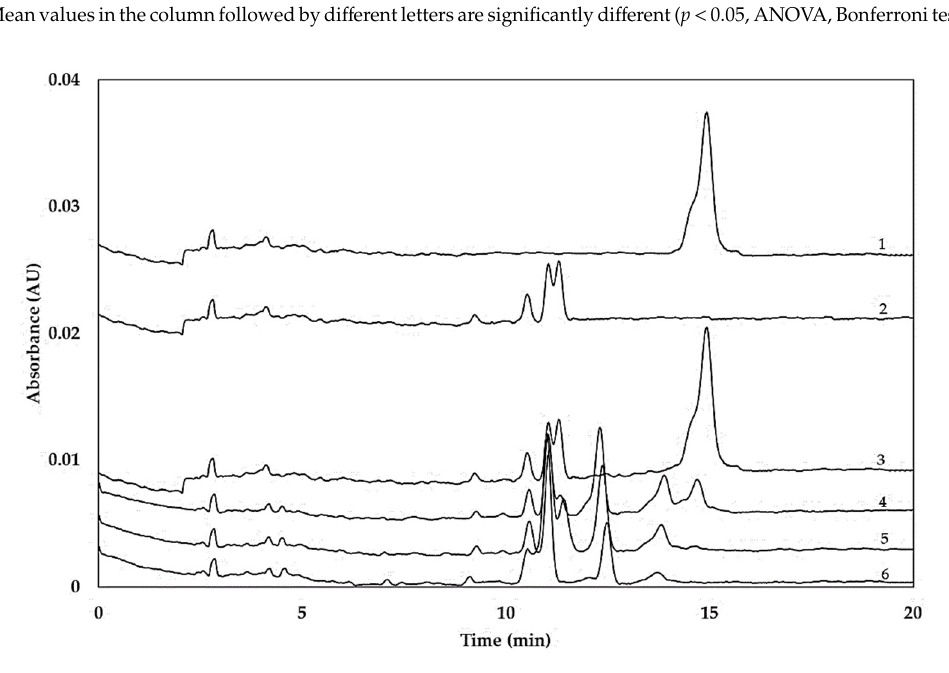
Figure 2. Electropherograms (FZCE) of peptide LGQQQPFPPQQPY (1), mixture of peptidases from L. acidophilus 5e2 and A. niger (2) and products obtained after 0 (3), 1 (4), 2 (5) and 3 h (6) of incubation at 37 ° C and pH 4.0. Table 4. Effect of reaction conditions on the degree of hydrolysis (DH, %), concentration of QQPFP sequence (C, mg/kg) and relative immunoreactivity (RI, %) of hydrolysed peptides: LGQQQPFPPQQPY (P1) and PQPQLPYPQPQLP (P2) by a mixture of peptidases from L. acidophilus